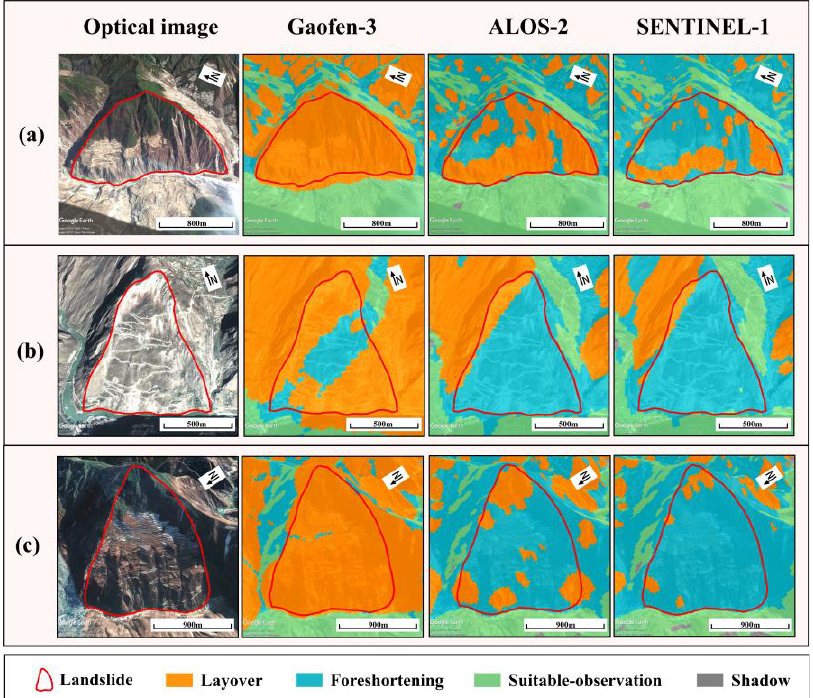
Figure 10. ( a – c ) Comparison of slope imaging for the facing-satellite slopes.